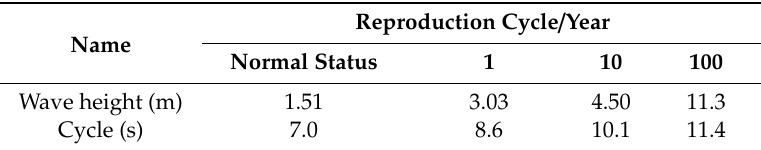
Table 2. Wave parameters.